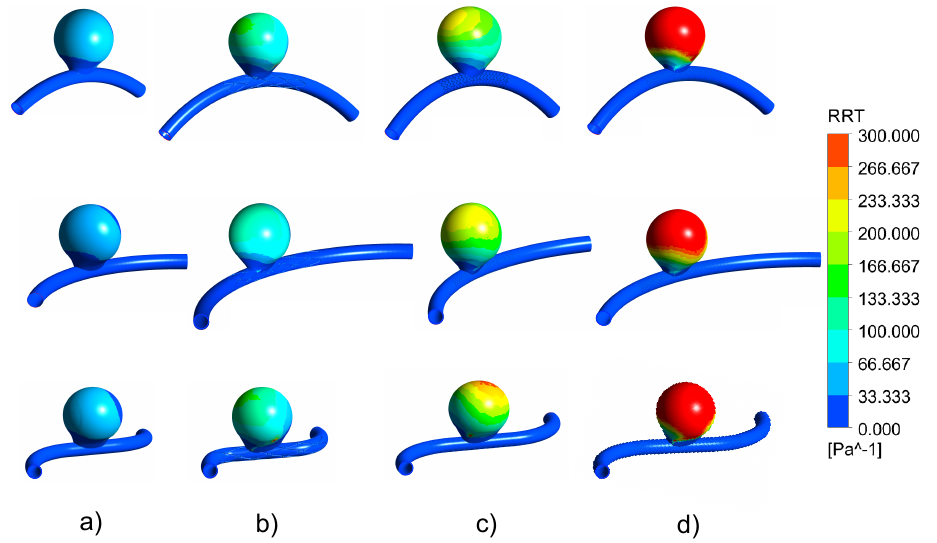
Figure 9. Spatial distribution of the relative residence time (RRT) for the three vessel configurations (top row, V-bent vessel; middle row, C-bent vessel; bottom row, S-bent vessel) and the three stents: ( a ) no stent, ( b ) STENT 1, ( c ) STENT 2 and ( d ) STENT 3.